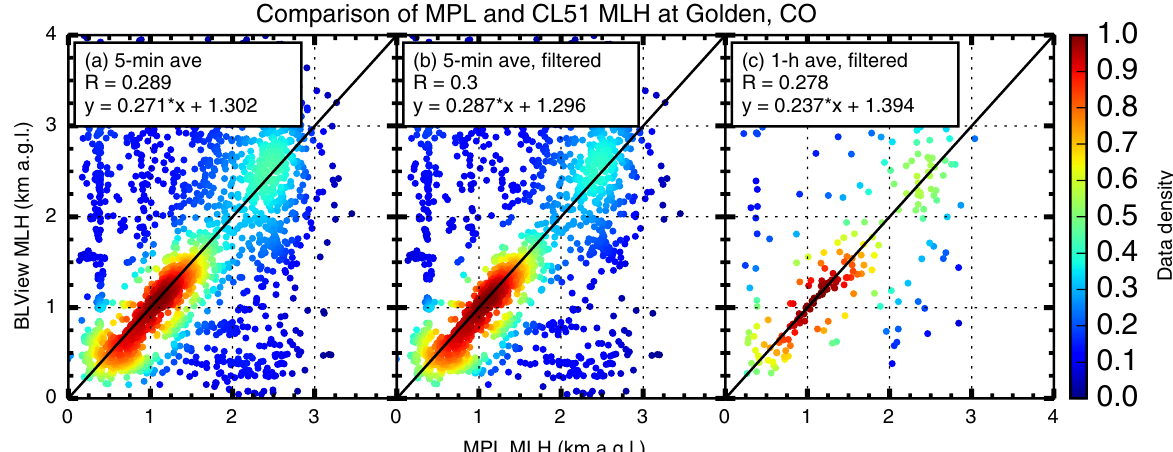
Figure 14. Correlation and data-density plots for the CL51 (BLView processed) and MPL (UMBC algorithm) MLH estimates from Golden, Colorado.